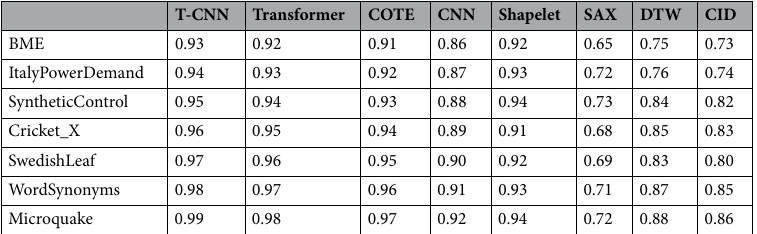
Table 3. Comparison of classification accuracy